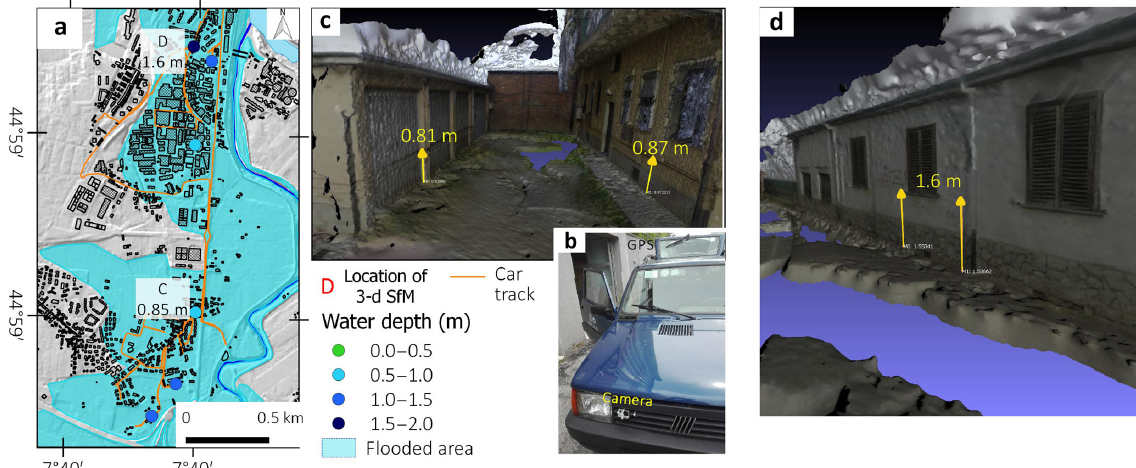
Figure 10. (a) Map of the flooded area by Chisola Stream in the Moncalieri municipality with measured water height and location of 3-D photo, (b) installation of the GO-PRO HERO 3 + (Black Edition) camera and GPS antenna over the car (the processing system for STANAG 4609 encoding was installed inside the car) (c) and (d) examples of 3-D models made with SfM in which it was possible to measure the water